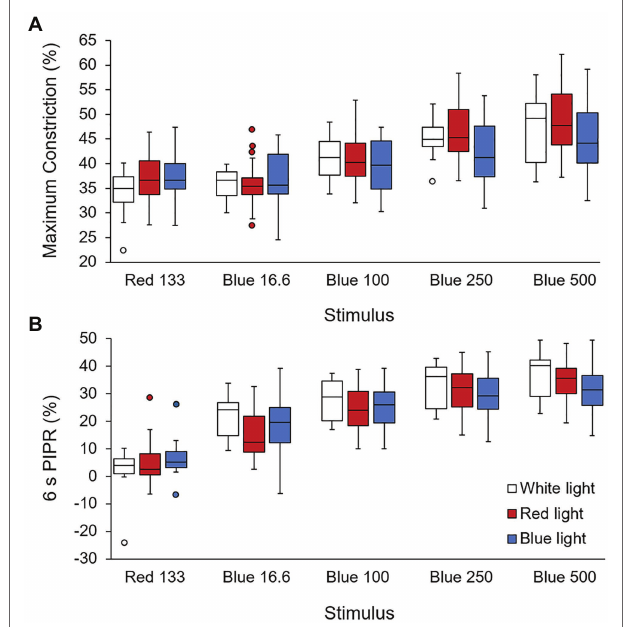
FIGURE 6 | (A) Maximum constriction (% change from baseline) and (B) the 6 s post-illumination pupil response (PIPR; % change from baseline) for 1 s red (133 cd/m 2 ) and four increasing intensities of blue (16.6, 100, 250, and 500 cd/m 2 ) stimuli for white light (open bars), red light (red bars), and blue light (blue bars) reared monkeys.